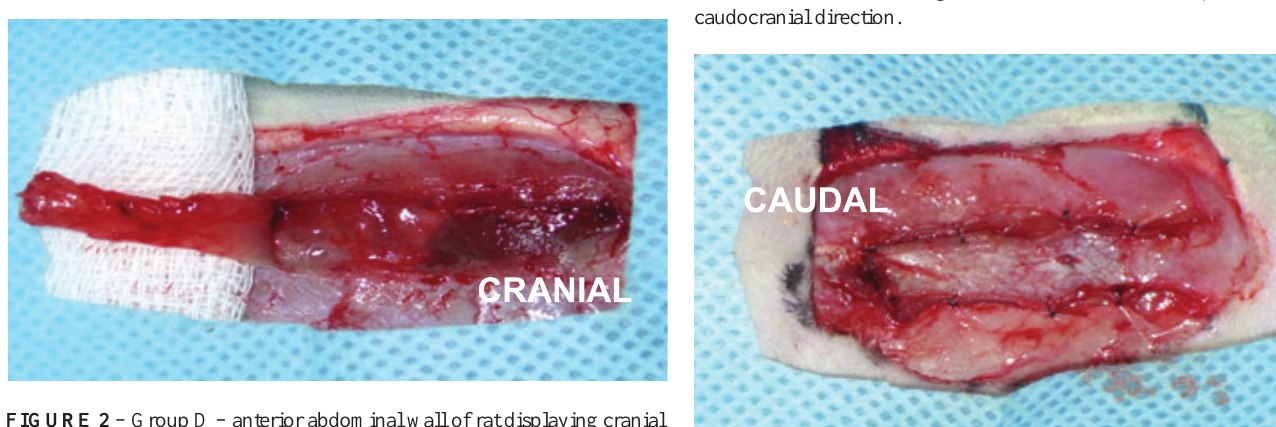
FIGURE 1 – Group C - anterior abdominal wall of rat displaying both cranial and caudal devascularization of the right rectus abdominis muscle.